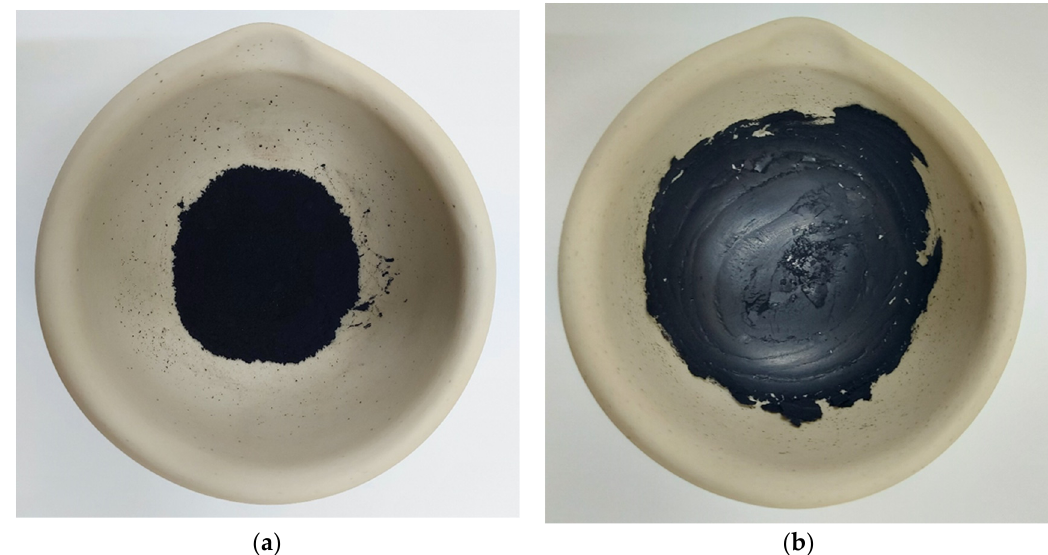
Figure 9. Preparation of the adsorbent material by grinding Composite A with the CNT, ( a ) before grinding, and ( b ) after grinding in the presence of a few drops of methanol solvent.